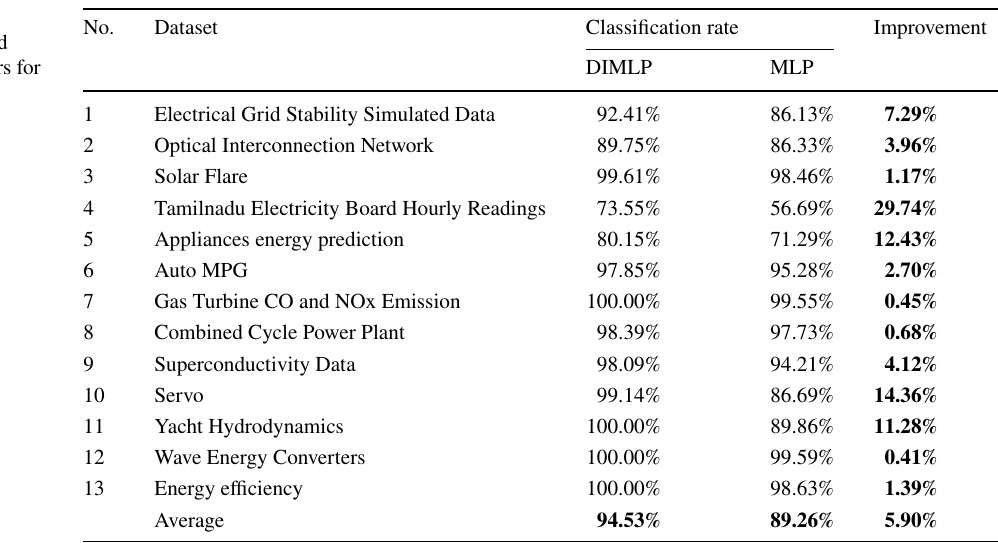
Bold values indicates the average and improvement